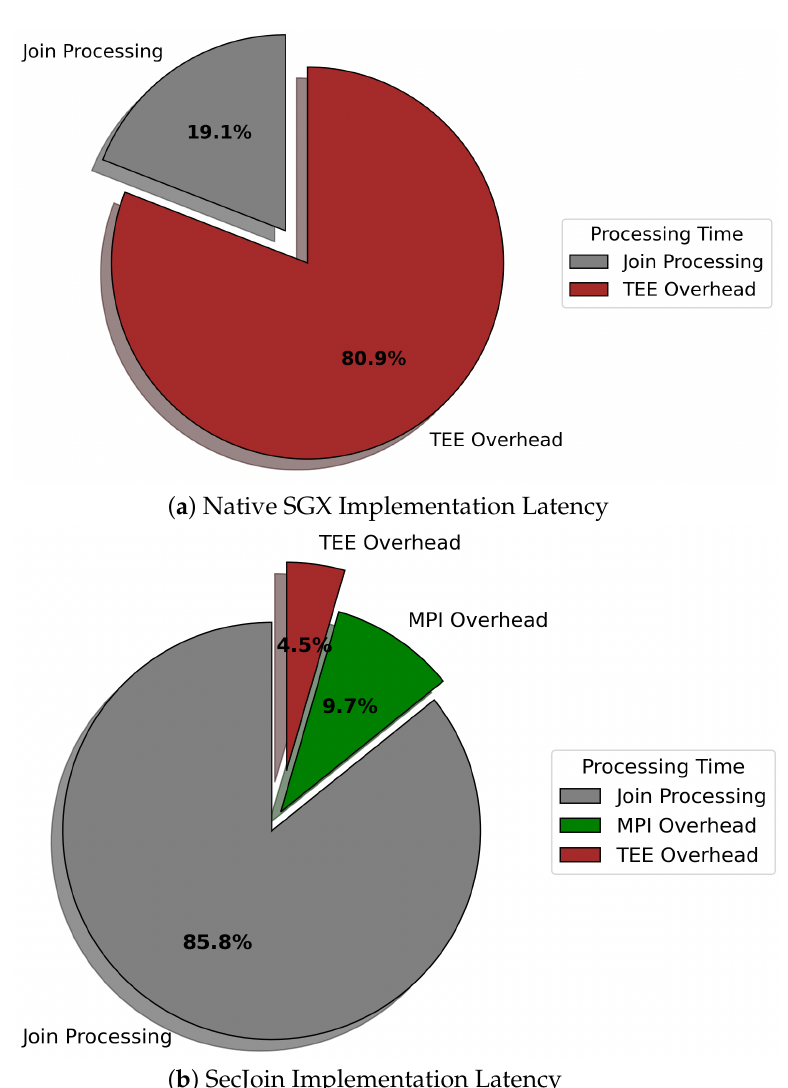
Figure 9. Breakdown of End-to-End Program Execution